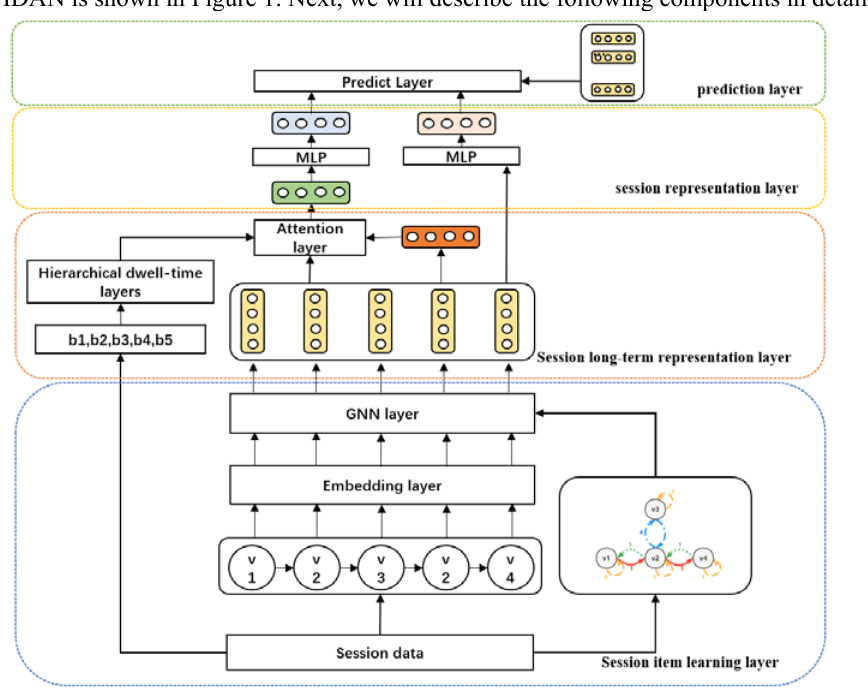
Fig. 1. GHDAN uses a multi-relational graph neural network with weights to implement messages between items and fits the long-term session embedding of a session by the dwell-time between items to make recommendations. It consists of the following four main components: Session item learning layer. Session long-term representation layer. Session representation layer. Prediction layer.